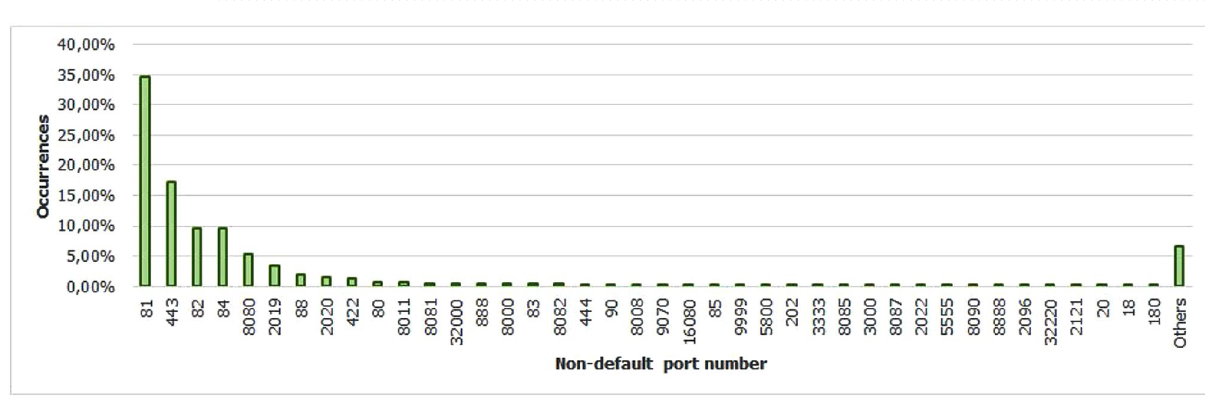
Figure 12. IP address encoded occurences.